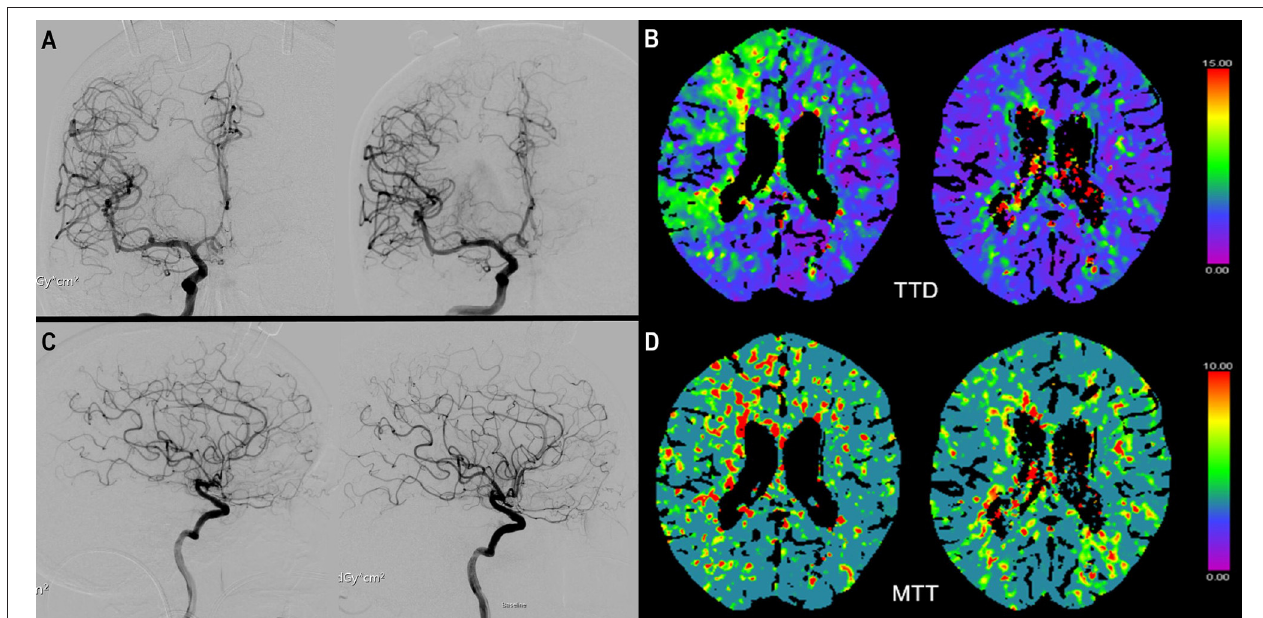
FIGURE 1 | (A) ap view of a digital subtraction angiography (DSA) of the right internal carotid artery (ICA) before (left) and after (right) start of iNO application. Not the vasospastic vessels before initiation of iNO in the middle cerebral artery (MCA) and anterior cerebral artery territory (ACA). (C) shows the respective lateral view before (left) and (after) initiation of iNO. (B) (TTD) and (D) (MTT) show the corresponding CTP examination with perfusion deficits in the MCA and ACA territory and improvement after iNO therapy (right